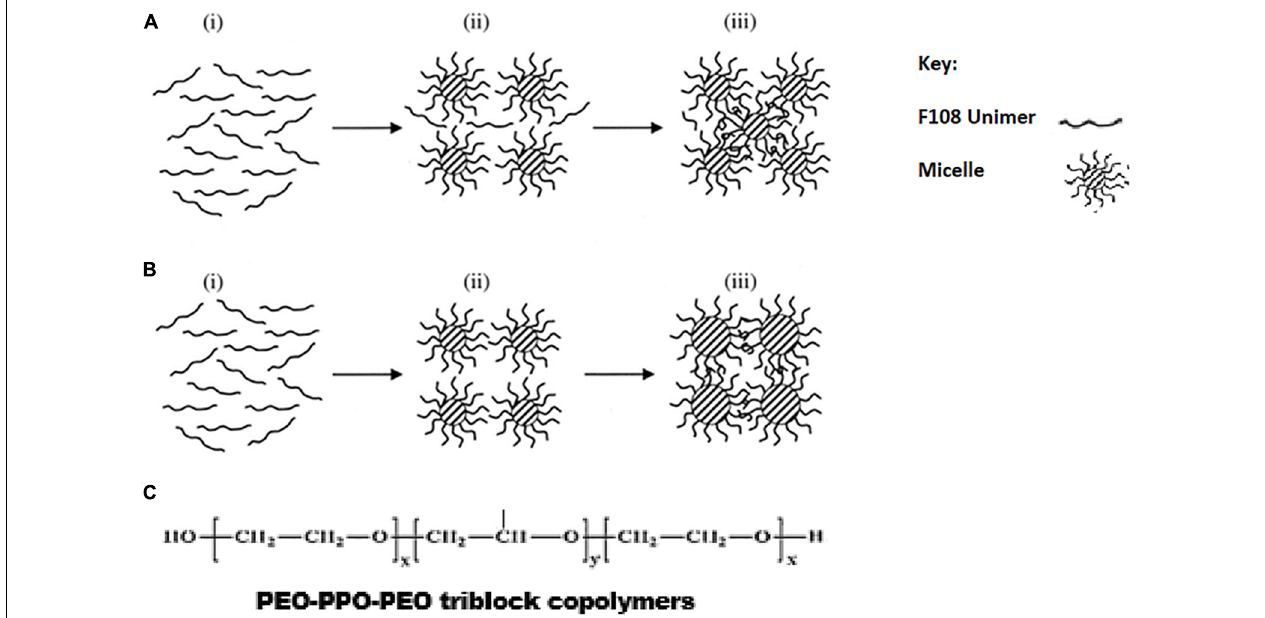
FIGURE 4 | Schematic diagram for two mechanisms (A,B) for the gelation of F108 through micellization. From stage i to stage iii, the arrows indicate the direction of increasing temperature. F108 molecules exist as unimers at stage i, and the micelles are formed during stage ii. In mechanism A, the micellar sizes remain the same, but new micelles are formed at stage iii so that the intermicellar distance is shortened and gelation through entanglements is allowed. In mechanism B, the number of micelles remains unchanged during stage iii, but their size is increased with temperature so that the intermicellar distance is shortened and gelation through entanglements is allowed. Reproduced with permission from Lau et al. (2004), John Wiley and sons. (C) Chemical structure of PEO-PPO-PEO triblock